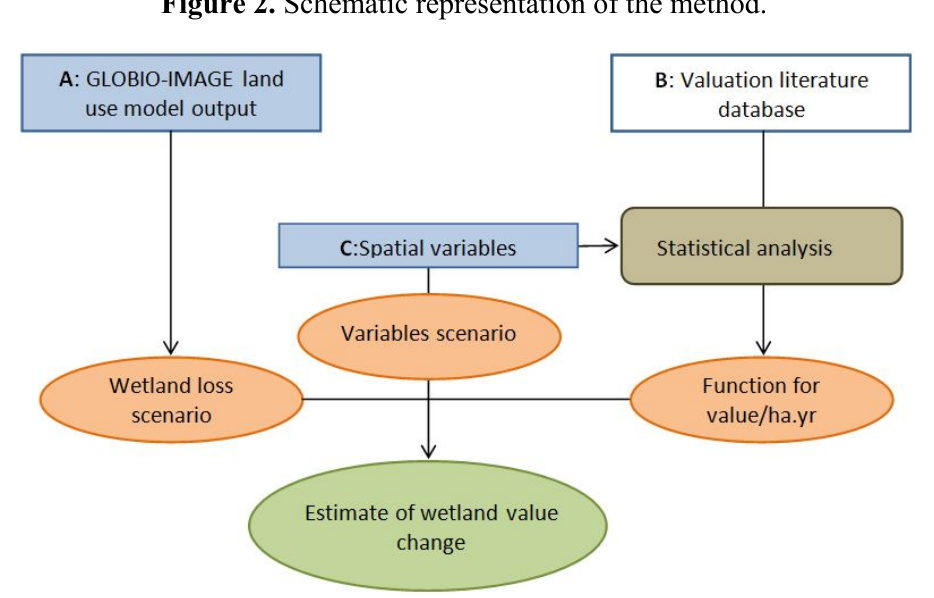
Figure 2. Schematic representation of the